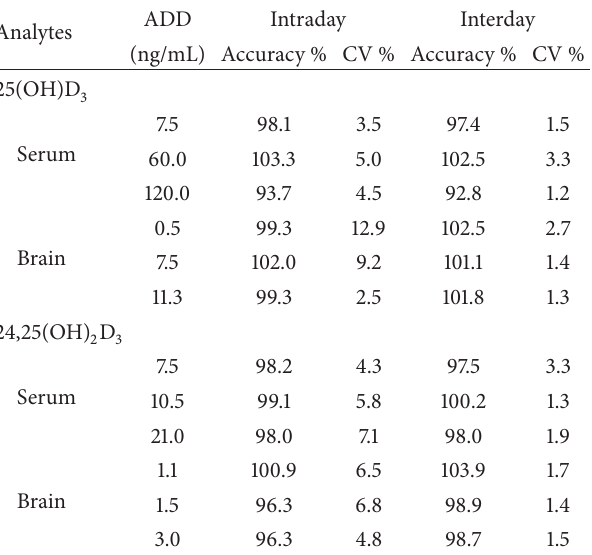
Table 3: Intraday and interday precision and recovery of rat brain homogenates and